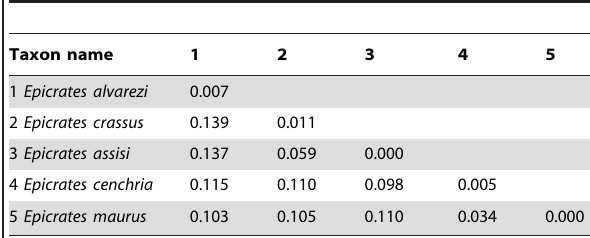
Table 4. Kimura’s two parameter (K2P) distance, for cytochrome b , within and among Eunectes